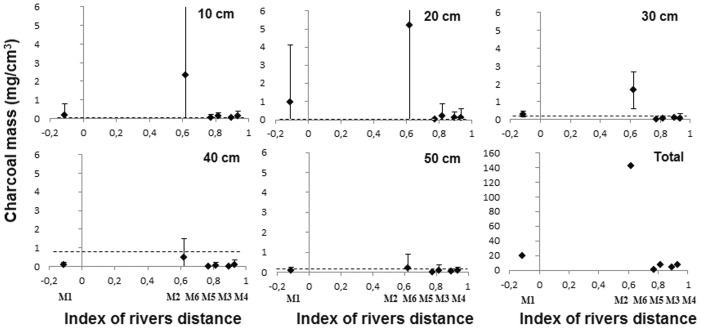
Mass of charcoal in the soil (mg/cm3) for each soil layer from 10 cm to 50 cm in depth.The plots are in order of increasing distance from the sites to the rivers, expressed by the index of rivers distances. Each point is the average mass of charcoal in the soil from 14–15 samples in each area. The vertical lines represent the standard deviation. The dotted line represents the median value of the mass of charcoal found at each depth in the soil of forests north of Manaus in Central Amazonia, which is the value expected in soils without past human activities [26].